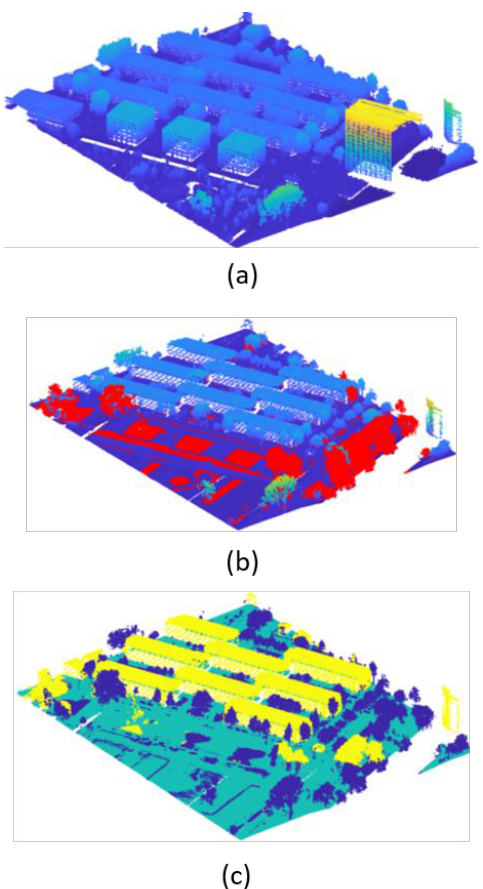
Figure 3. In order to get a rough estimate of mislabelled points in AHN2 after assigning the closest label from AHN3 to each point, the assignment distance is employed. (a) AHN3 point cloud. (b) AHN2 point cloud, points in red represent areas subjected to changes between both scans that are therefore likely to be wrongly labelled. (c) point cloud labelled with three classes: